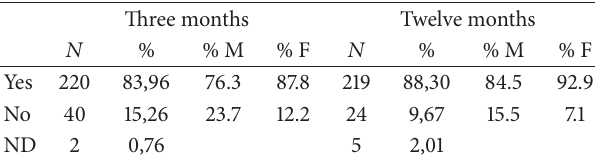
Table 8: “Would you tell your neurologist you did not follow his